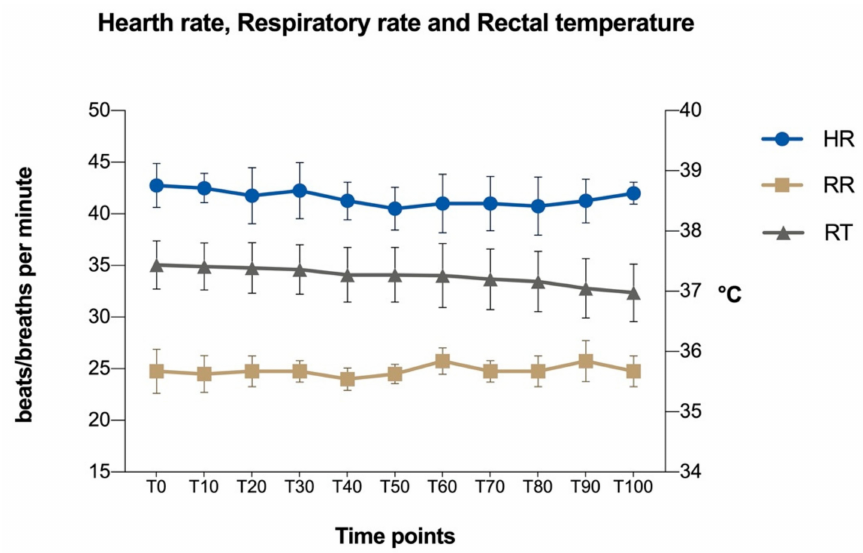
Figure 3. Mean values ± standard deviation of heart rate (HR, beats/min), respiratory rate (RR, breaths/min) and rectal temperature (RT, ◦ C) during the study. Time points, T0: baseline; from T10 to T100: measurements from the start of the surgery until the end of the